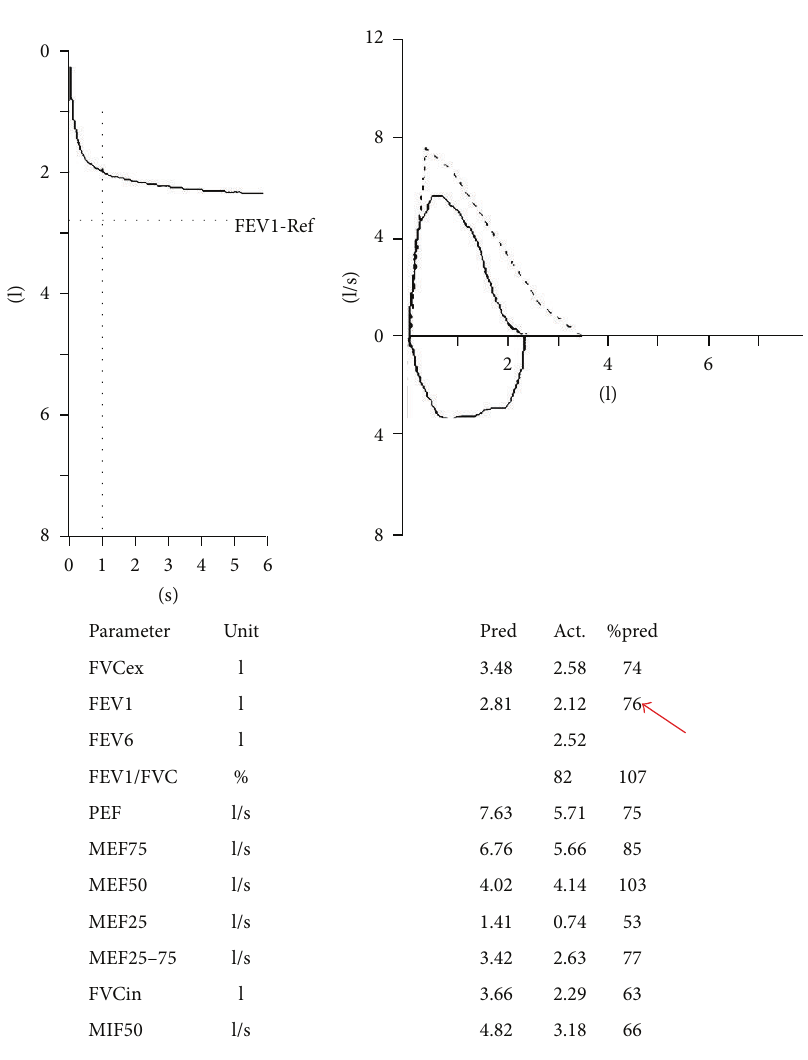
There is little information about the endoscopic